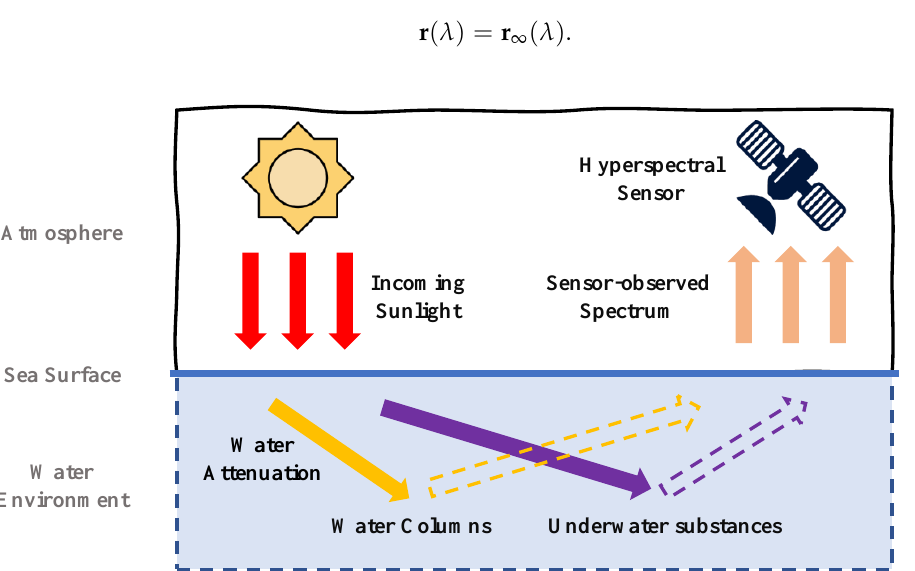
Figure 1. An illustration of the generation process for sensor-observed